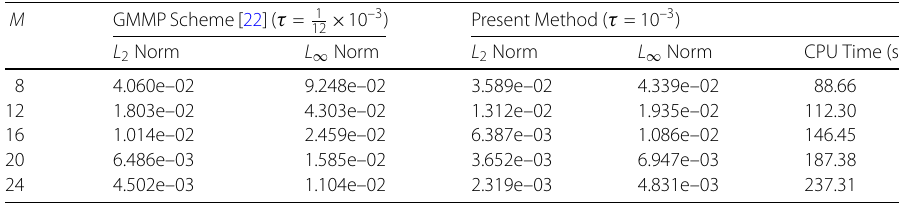
for Example 2 M